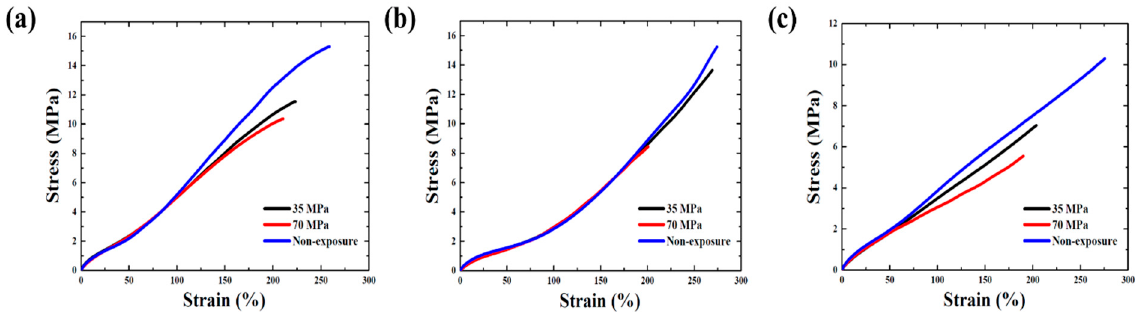
Figure 8. Stress-strain curves of ( a ) NBR, ( b ) EPDM, ( c ) FKM.